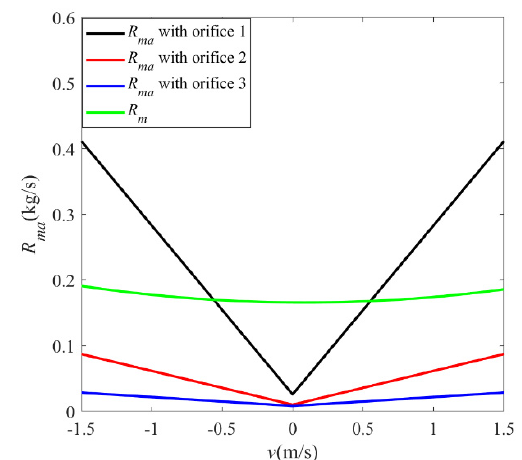
Figure 7. Comparison between the identified values of the equivalent mechanical resistance R ma ( v ) and the measured mechanical resistance R m ( v ).